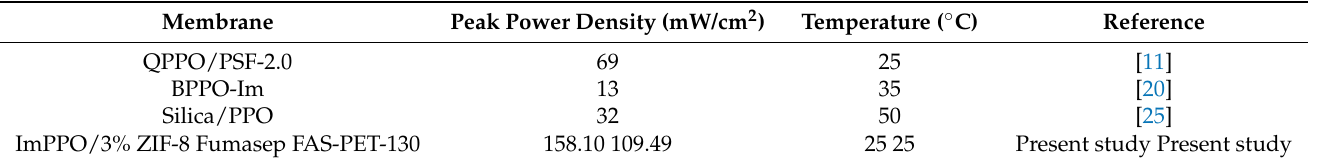
Table 3. Comparison of ImPPO/ZIF-8 with reported